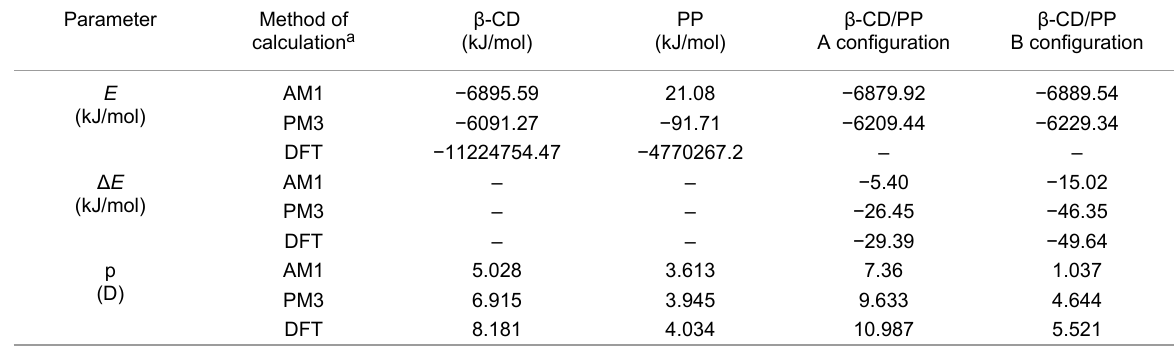
Table 1: Molecular parameters of the most stable β -CD/PP inclusion compounds in both A and B configurations, as given by AM1 and PM3 calcula- tions and by B3LYP/6-31G(d)+ single-point calculations applied on the PM3 optimized geometries.